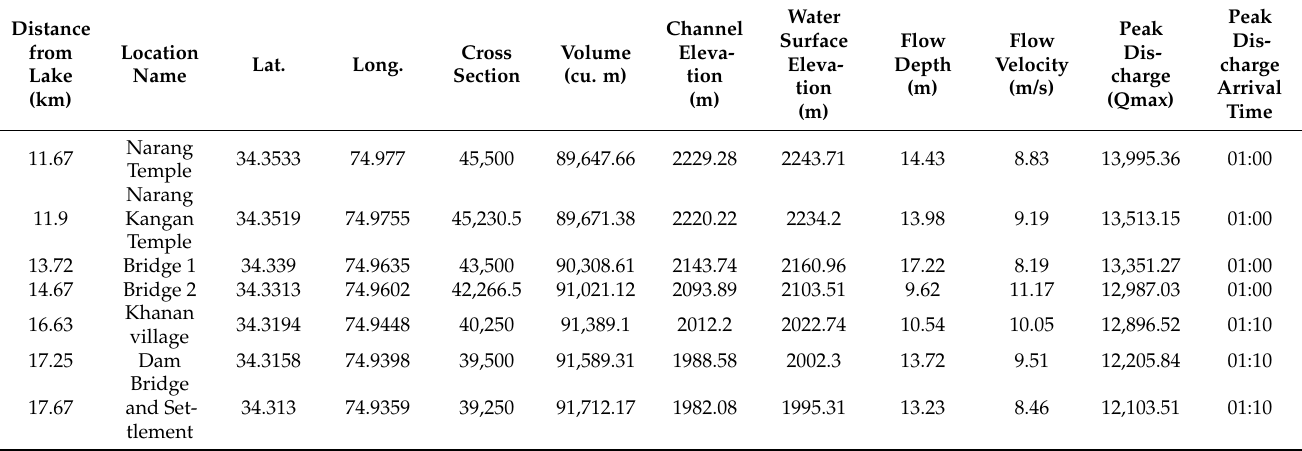
Table 6. Flood wave parameters at various important